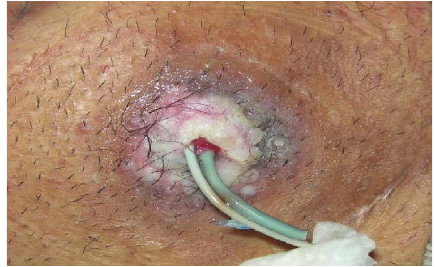
Figure 3: View of the ostomy following